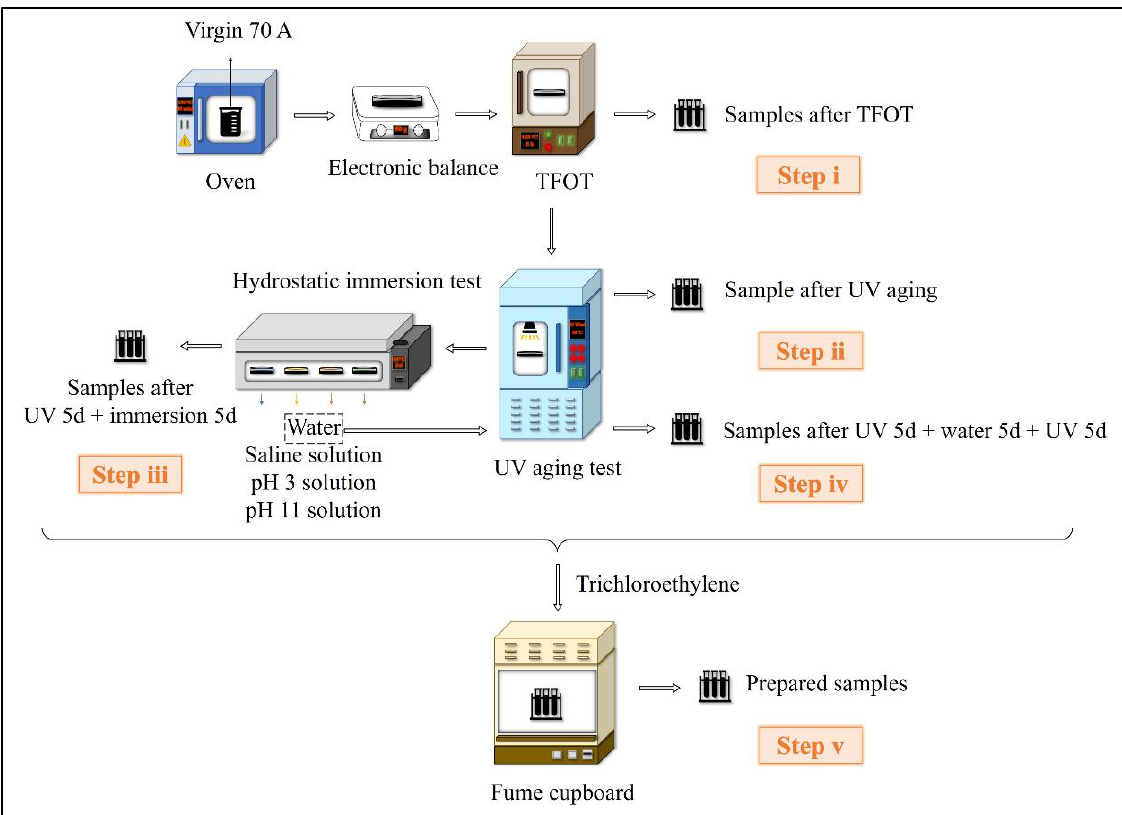
Figure 2. Sample preparation procedure.